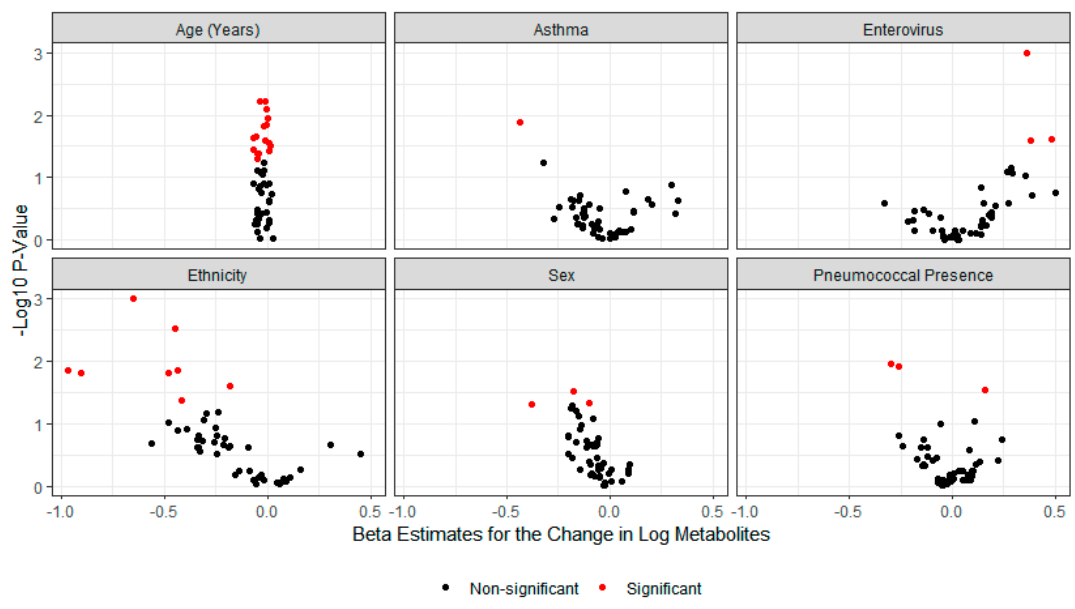
Figure 2. Each plot shows the -log 10 of the nominal p -value on the y -axis and the log 10 fold change in metabolite concentration on the x -axis for the 122 children. Red points toward the top left represent statistically significant ( p < 0.05) negative fold changes in metabolite concentrations, while red points toward the top right represent statistically significant positive fold changes in metabolite concentrations for each variable. Metabolites associated with age include valine, lysine, formate, creatine, 2-aminobutyrate, 2-oxoglutarate, tryptophan, betaine, quinolinate, hydroxyisovalerate, and hypoxanthine. 1-Methylnicotinamide was statistically associated with asthma. Quinolinate, 3-indoxylsulfate, and citrate were statistically associated with rhinovirus/enterovirus. Ethnicity was statistically associated with alanine, tryptophan, propylene glycol, threonine, betaine, histidine, ethanolamine, and 2-oxoglutarate. Sex was associated with cis-aconitate, threonine, and propylene glycol. Pneumococcal presence was associated with TMAO, hippurate, and citrate.